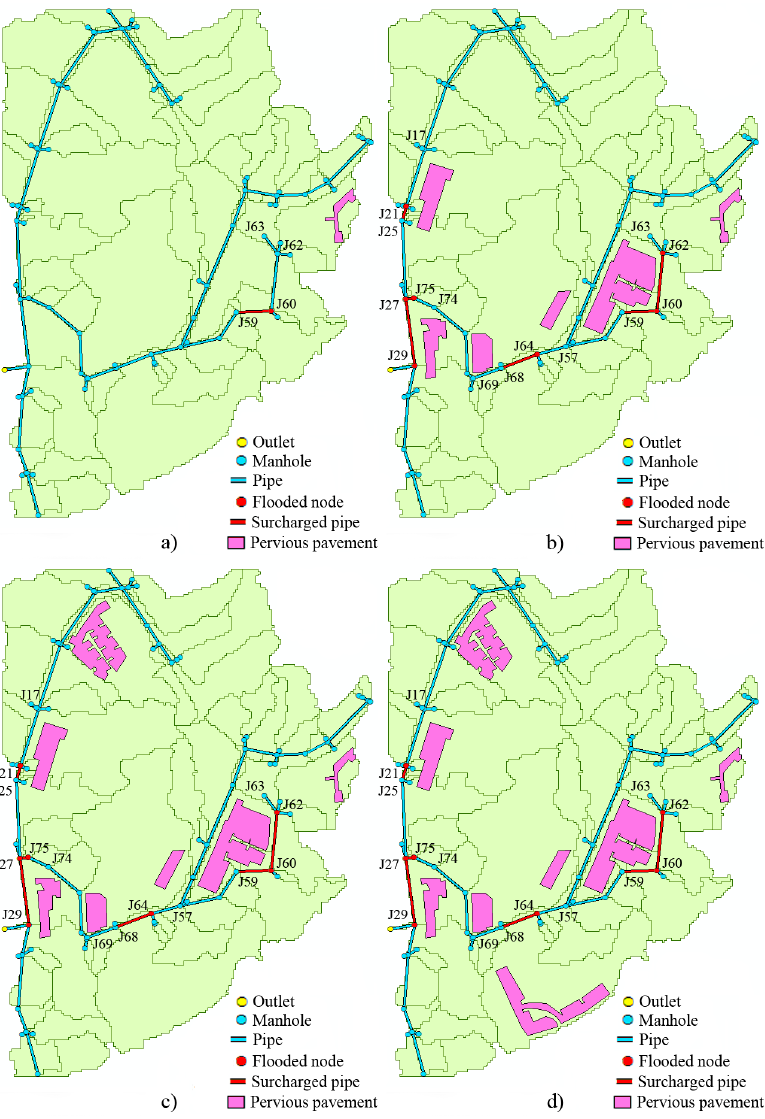
Figure 7. Location of Permeable Pavement Systems (PPS) to avoid flooding under different climate scenarios and return periods (T): ( a ) RCP4.5; T = 2 years; ( b ) RCP8.5; T = 2 years; ( c ) RCP4.5; T = 10 years; and ( d ) stationary; T = 50 years.